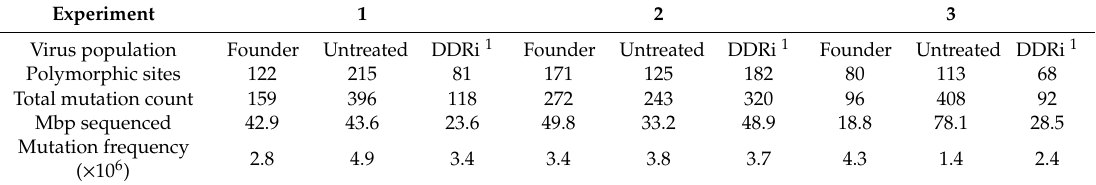
Table 1. Sequence diversity of Ad5 passaged in DDR-inhibited or untreated